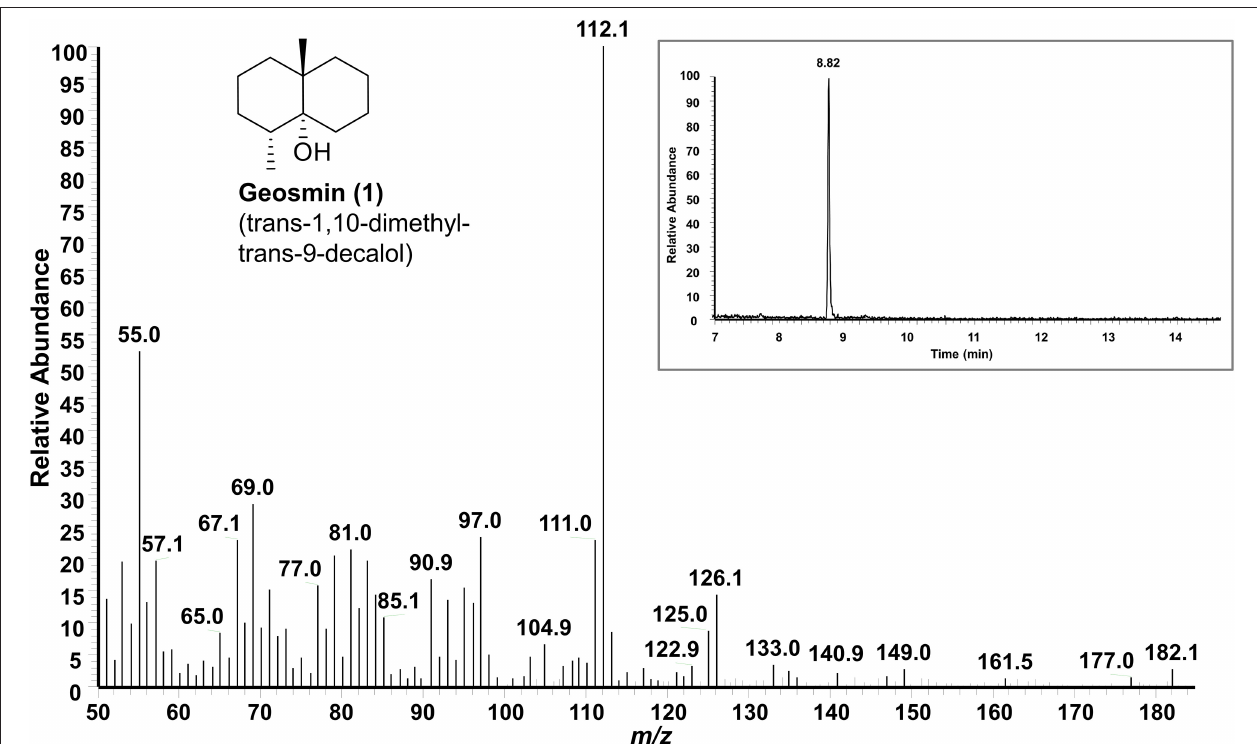
FIGURE 4 | GC-MS spectrum of the volatile semiochemical geosmin ( 1 ) produced by endophytic S. pulveraceus ES16 on PDA under stress and during sporulation. Insert shows the GC chromatogram (RT 8.82min) of geosmin ( 1 ).